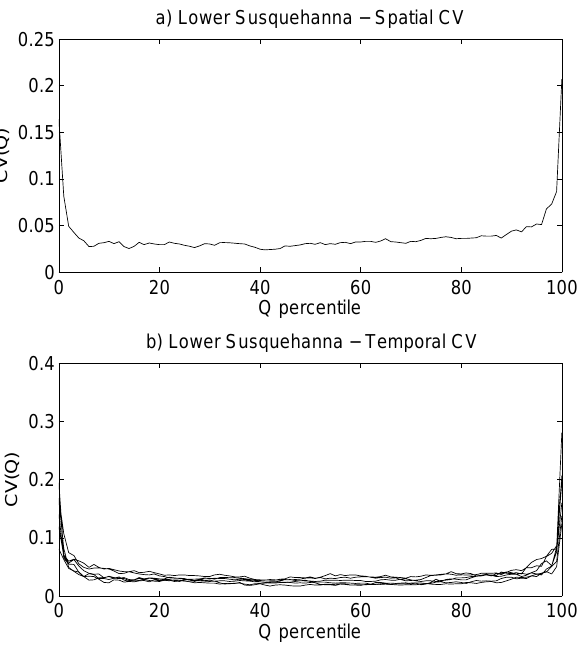
Fig. 9. CV patterns of synthetically generated random time-series that have the same probability distributions as the streamflows of catchments in Lower Susquehanna basin: (a) Spatial CV, (b) Tem- poral